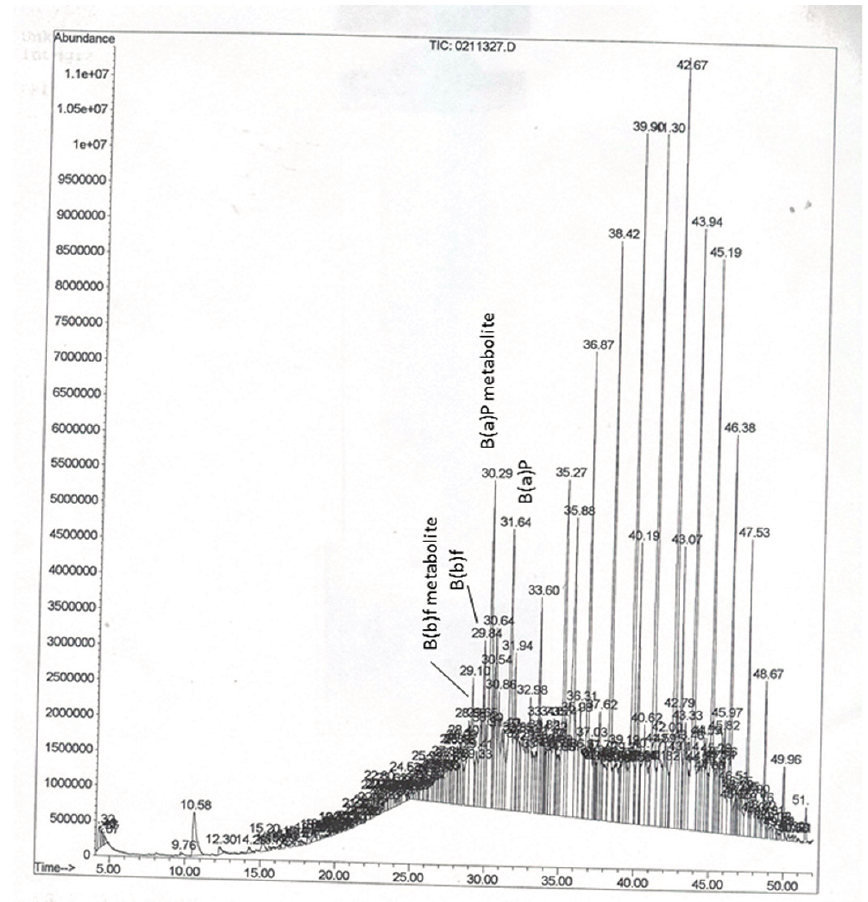
Figure 3. Representative GC-MS chromatogram of PAHs in serum samples of an African American male. The benzo(b)fluoranthene.